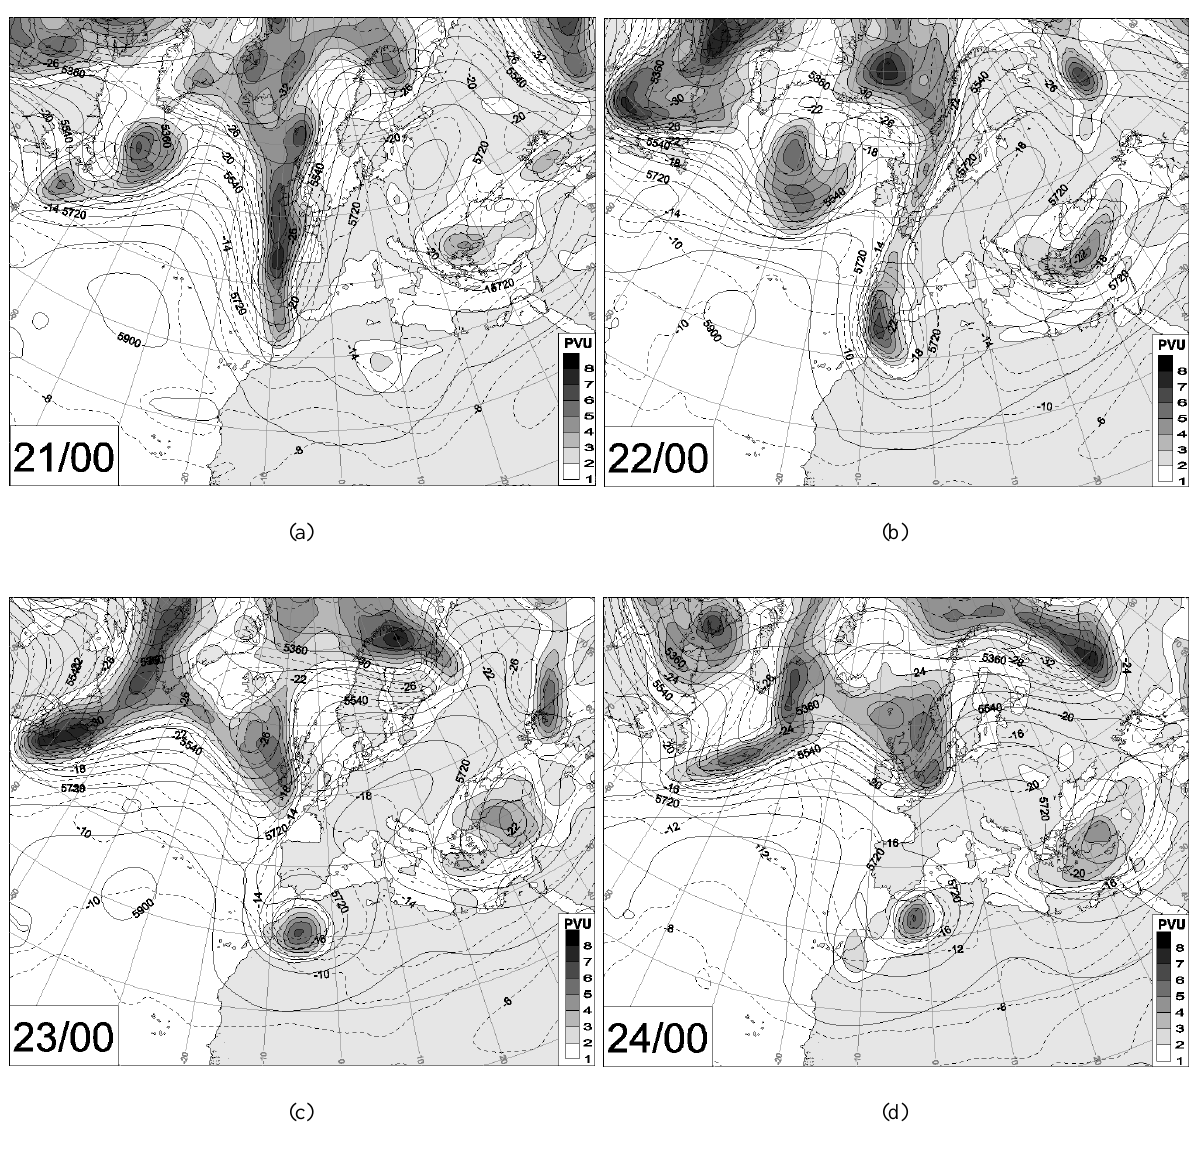
Fig. 3. Potential vorticity (PVU, shaded contours) at 300hPa, geopotential height (gpm, solid line) and temperature ( ◦ C, dashed line) at 500hPa on 00:00UTC (a) 21, (b) 22, (c) 23, (d) 24 October 2000, as diagnosed from the NCEP